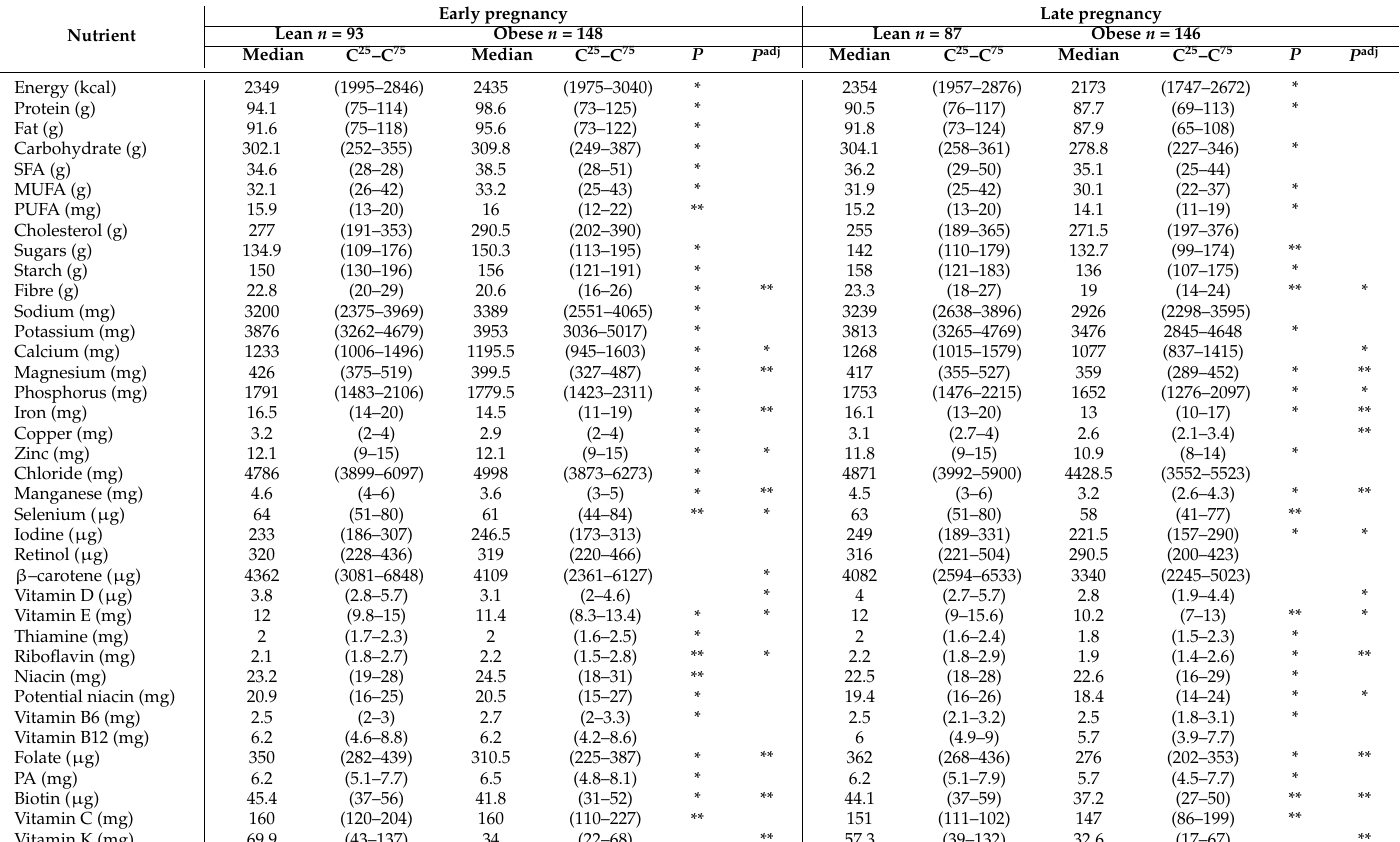
Table 2. Reported daily nutrient intakes in lean and very severely obese women in early and late